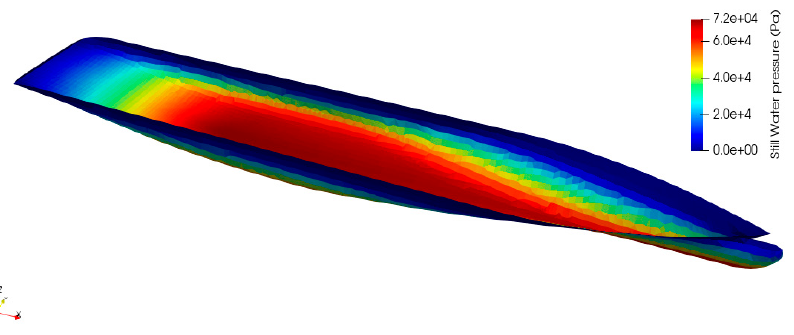
Figure 4. Still water pressure on the hull.